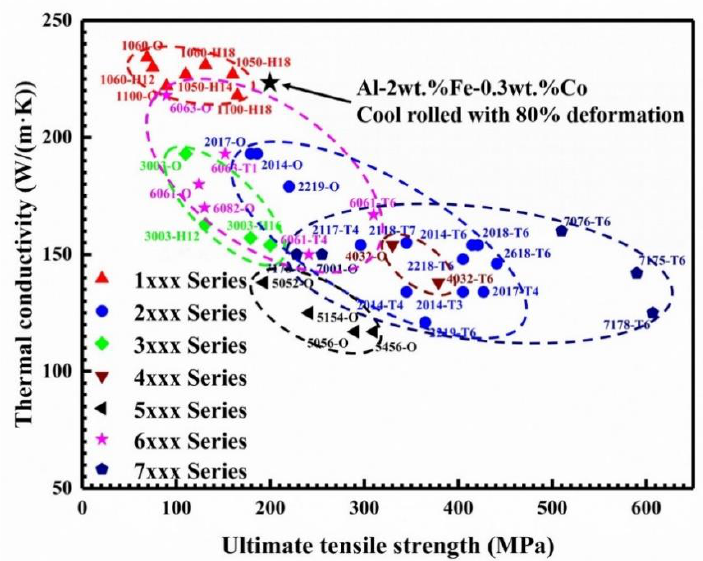
Figure 10. The correlation between the thermal conductivity and ultimate tensile strength of commercial wrought aluminum alloys.